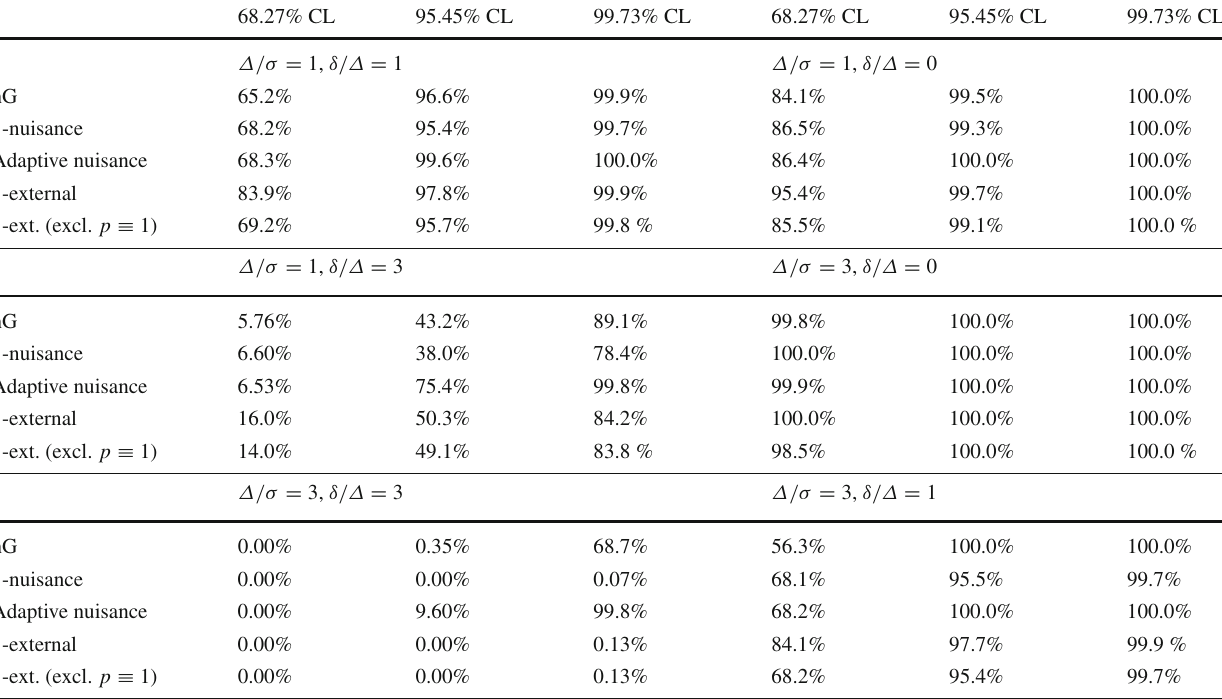
Table 5 Coverage properties of the various methods at 68.27, 95.45 and 99.73% CL, for different true values of δ/Δ contained in, at the border of, or outside the fixed volume Ω , and for various relative sizes of statistical and theoretical uncertainties